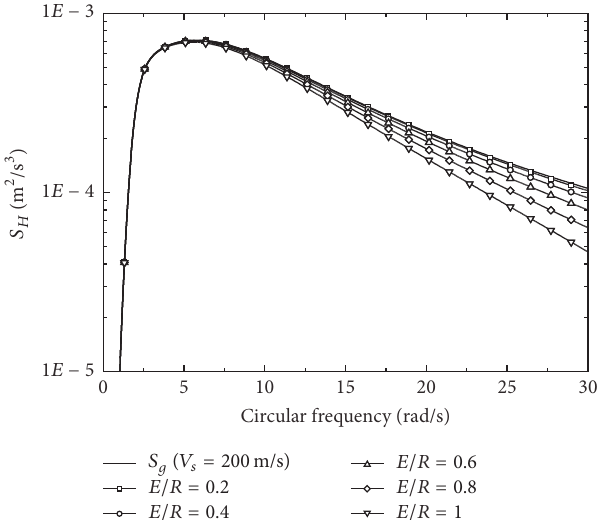
Figure 5: The translational PSDF component.